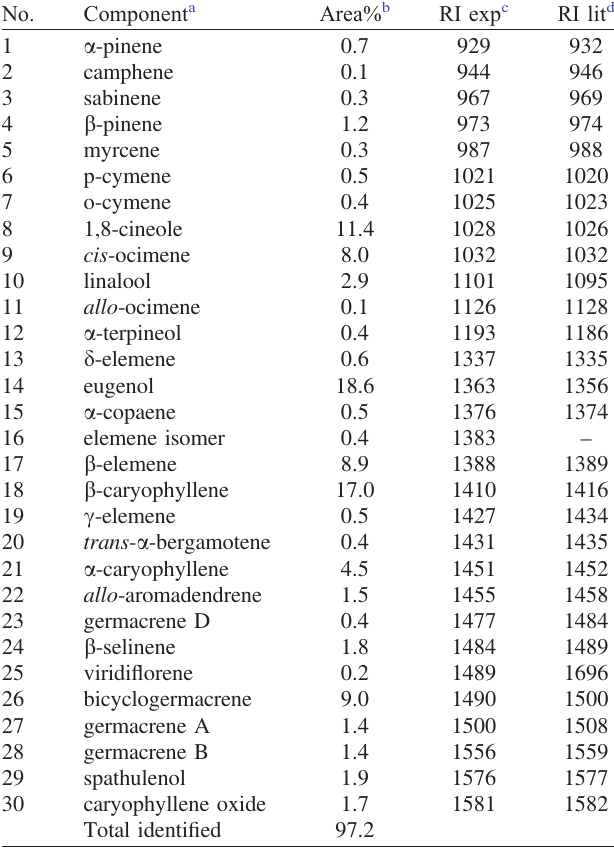
Table 1. Chemical characterisation of essential oil from leaves of Ocimum campechianum